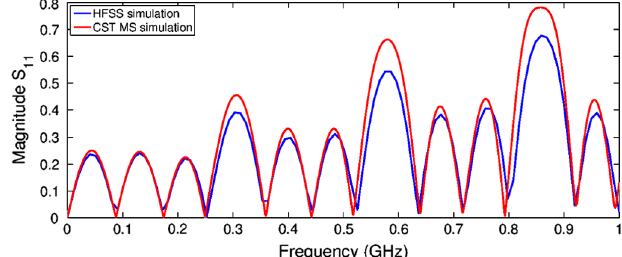
FIG. 12. Magnitude of S 11 predicted by HFSS and CST MS, for half-moon electrode striplines with four equally spaced Macor ring supports, and ideal 50 Ω feedthroughs.